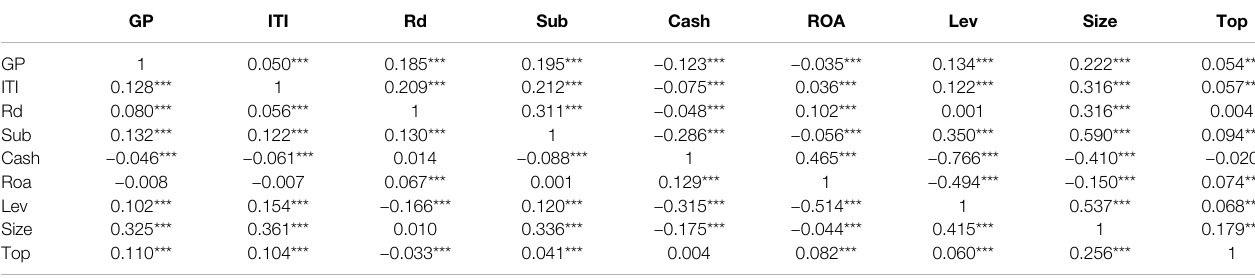
TABLE 3 | Correlation coef fi cient analysis of major variables.